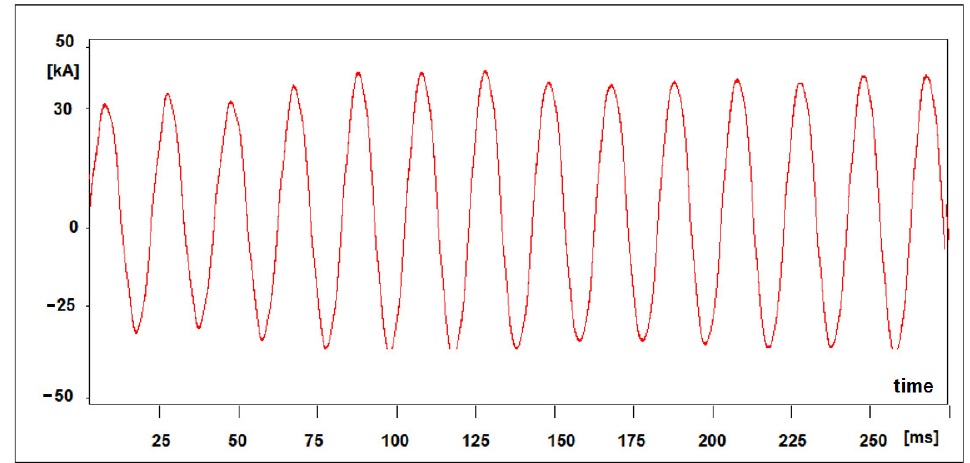
Figure 5. Oscillogram of the current with complete melting of the charge in the electric arc furnace.